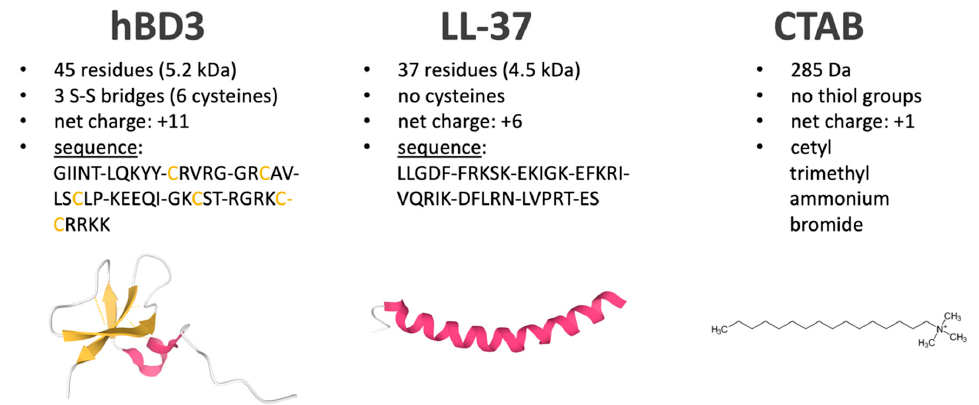
Figure 1. Characteristics of applied stress inducing components hBD3, LL-37, and CTAB. Beta-sheets and cysteines are colored in orange. Alpha-helices are colored in magenta. hBD3 structure (PDB ID: 1KJ6) was obtained from [7] and LL-37 structure (PDB ID: 2K6O) from [8]. Images of structures were created using Mol* [9].